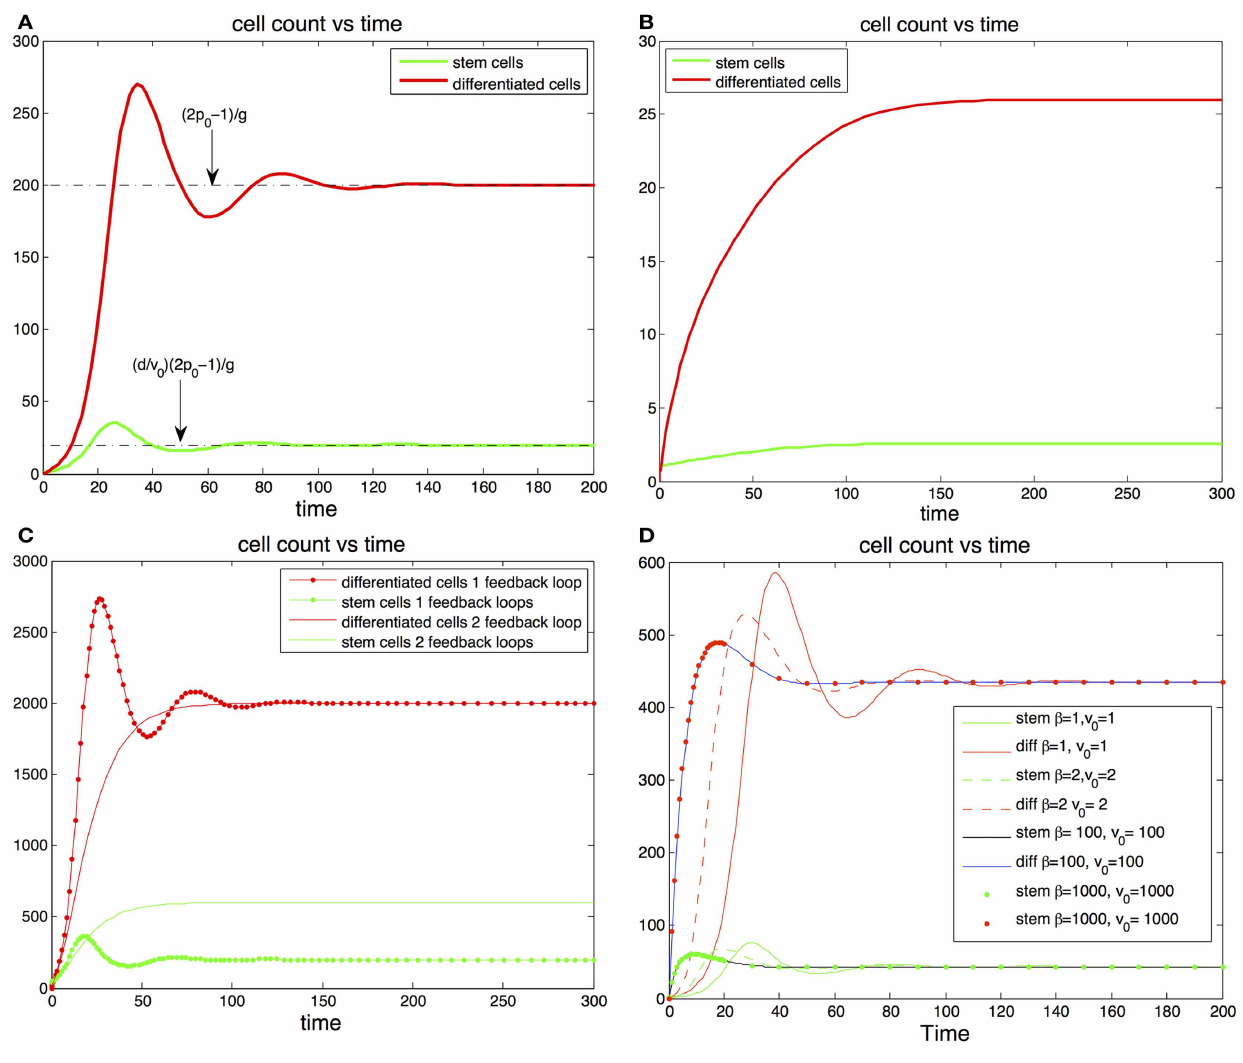
FIGURE 2 | (A,B) Cell population with one feedback loop. (A) The trajectories oscillate toward steady state values (dotted line). Parameters, p 0 = 0 . 6 , d = 0 . 1 , g = 0 . 001 , S (0) = 1 , D (0) = 0 . (B) If there is only one feedback loop the maximum self-renewal probability must be very close to 0.5 to ensure that the trajectories approach the steady states monotonically. In this subfigure d and g are the same as in (A) but p 0 = 0.513 . (C,D) cell population with two feedback loops. (C) The steady state number of differentiated cells depends only p 0 and g and is